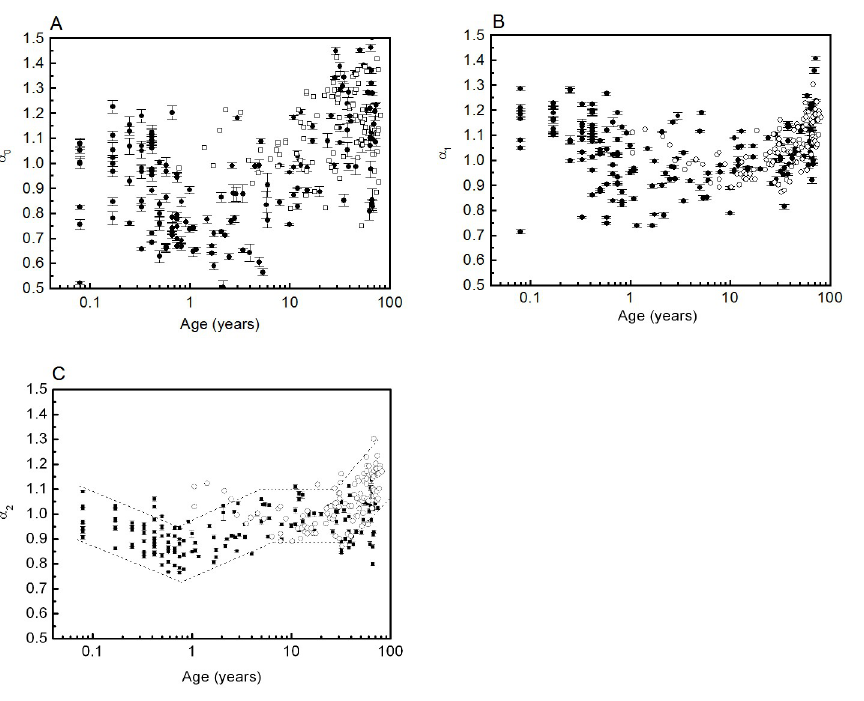
Fig 3. α 0 (A), α 1 (B), and α 2 (C) dependence on age. Filled circles correspond to data obtained in this work, and open squares and open circles correspond to data from [34], for α 0 and α 1 respectively. Note that in [34] α 1 was determined for s > 11. In (C) the dashed lines indicate the approximate 95% prediction interval (see Procedure).